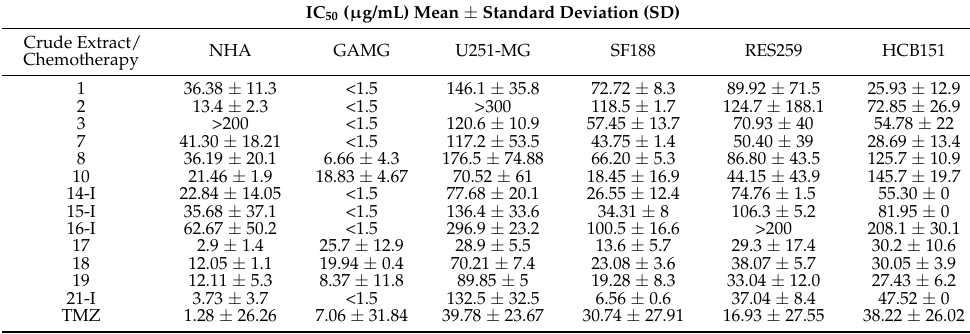
Table 1. Mean and standard deviation of IC 50 ( µ g/mL) values for crude leaf extracts from plants of the Brazilian cerrado biome and the chemotherapy temozolomide, evaluated at 72 h. IC 50 ( µ g/mL) Mean ± Standard Deviation (SD) Crude Extract/ Chemotherapy NHA